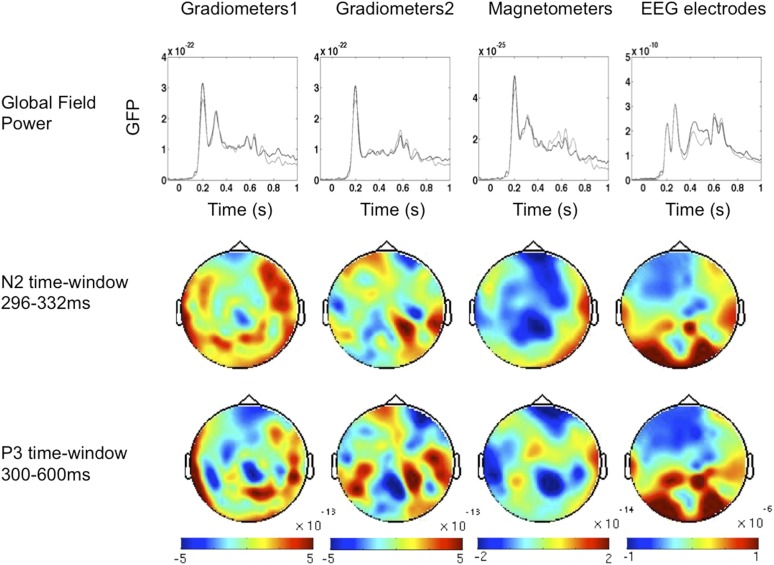
Event-Related Fields and potentials for ‘UnSeen–Correct’ vs ‘Unseen–InCorrect’.ERF and ERP components time windows were determined according to the global field power (upper panel). Two time windows were chosen; on each time window, cluster analysis was performed. No significant differences were found.